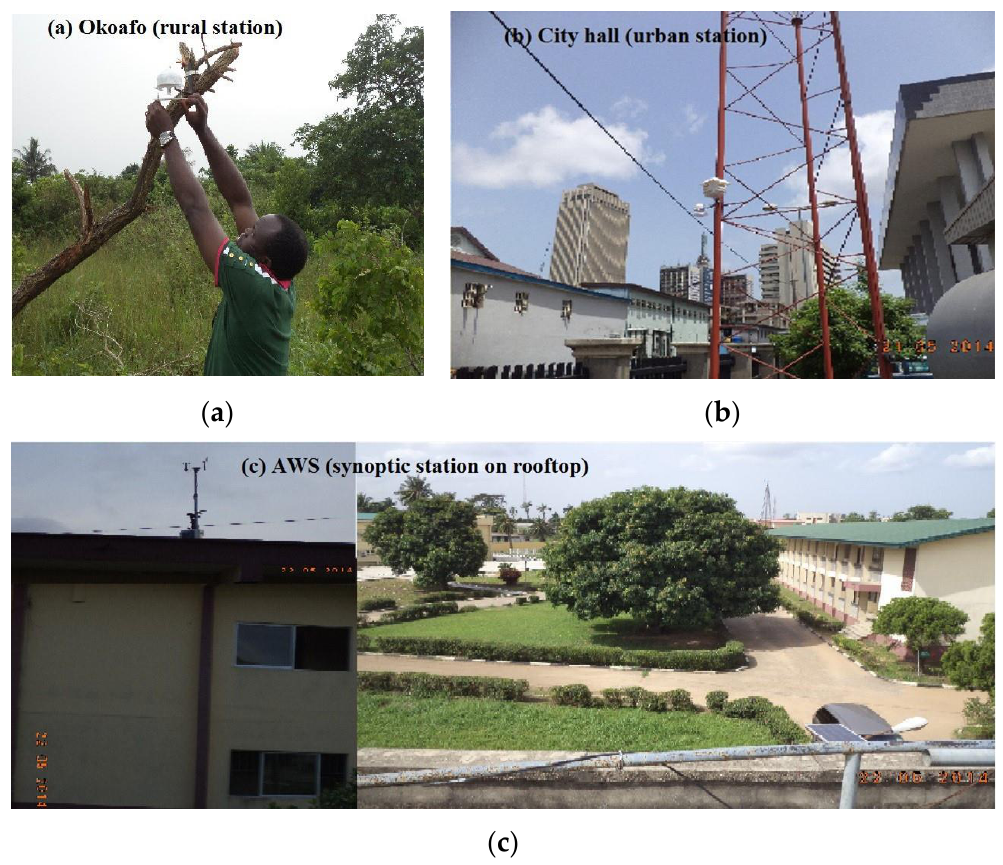
Figure 3. Datalogger sites in ( a ) Rural (Okoafo); ( b ) Urban (City Hall) and ( c ) Automatic Weather station (AWS) located on the rooftop of a one storey building at the Nimet premises in (Oshodi) used for the study (see Appendix for Google images of the locations). Table 1. Summary of site characteristics. Table 1. Summary of site